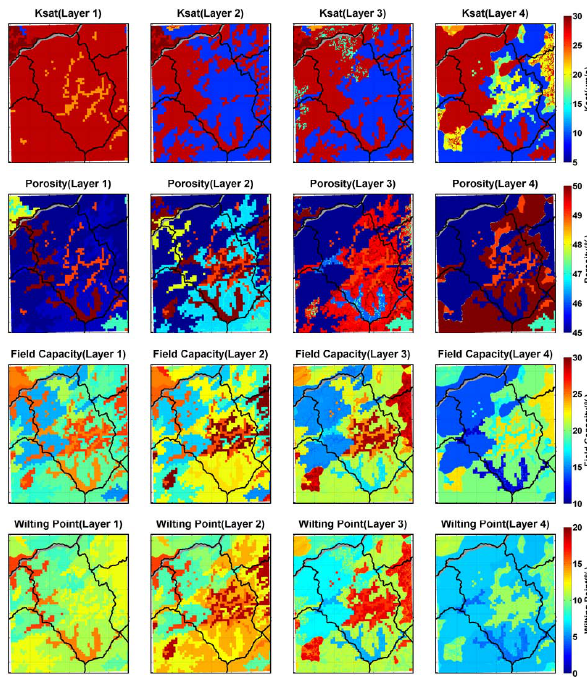
Fig. 7. The saturated hydraulic conductivity, soil porosity, field ca- pacity, and wilting point extracted from the State Soil Geographic (STATSGO) database for four soil layers from the left to right, ac- cording to spatially varying soil